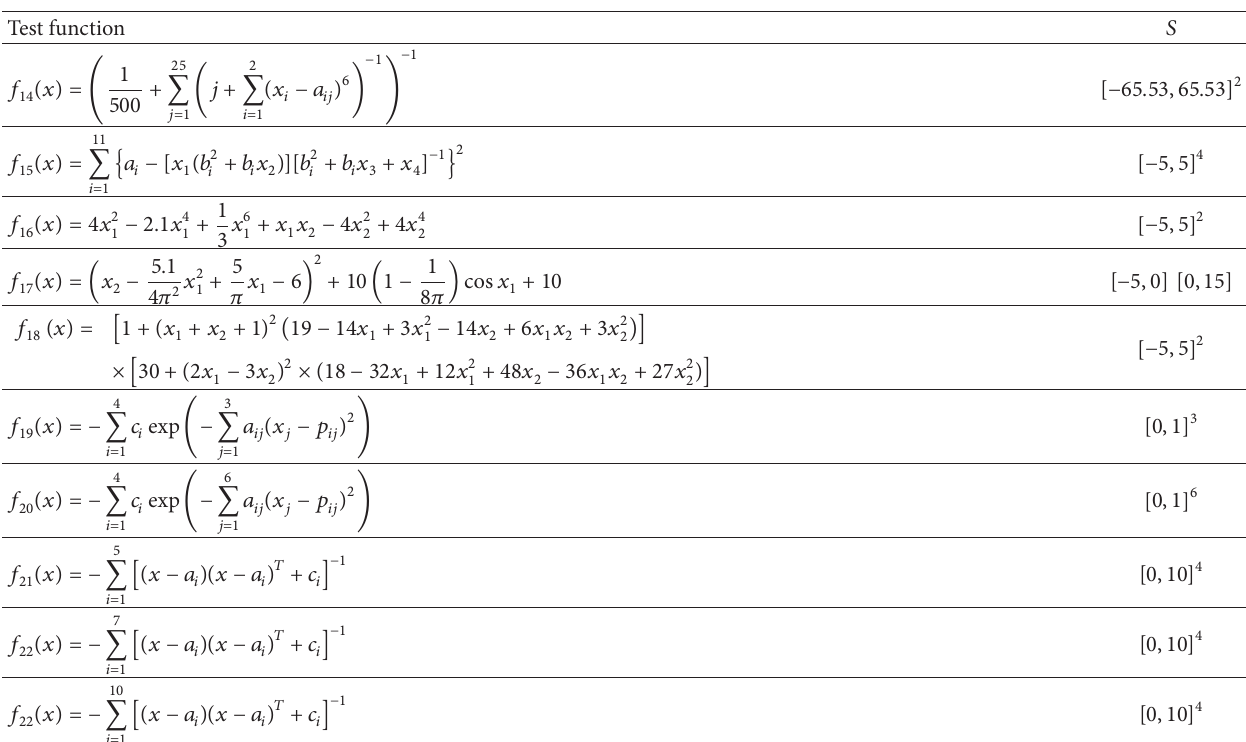
Table 3: Multimodal test functions with fix